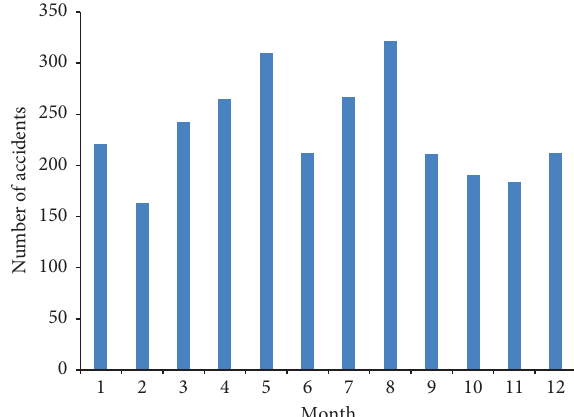
Figure 2: Accident date dimension